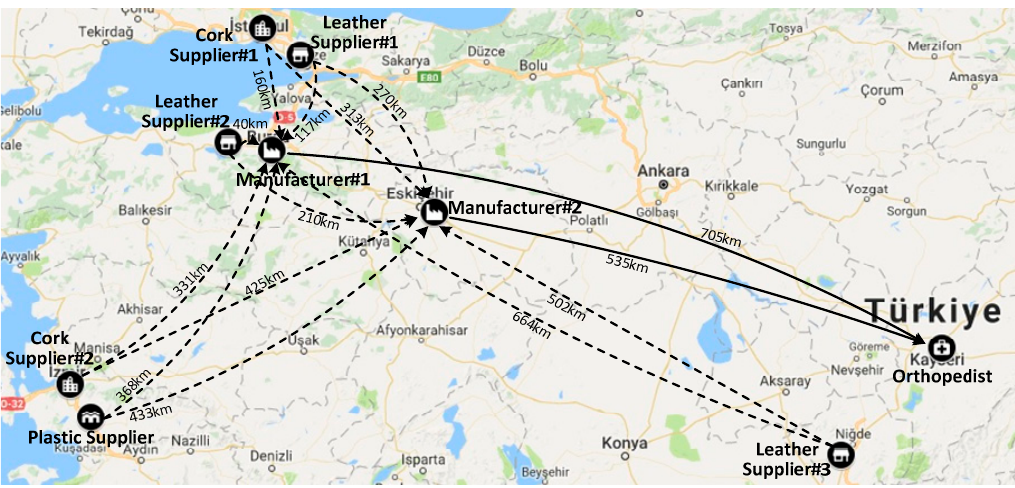
Figure 5. Traditional supply chain network for the orthopedic insole.